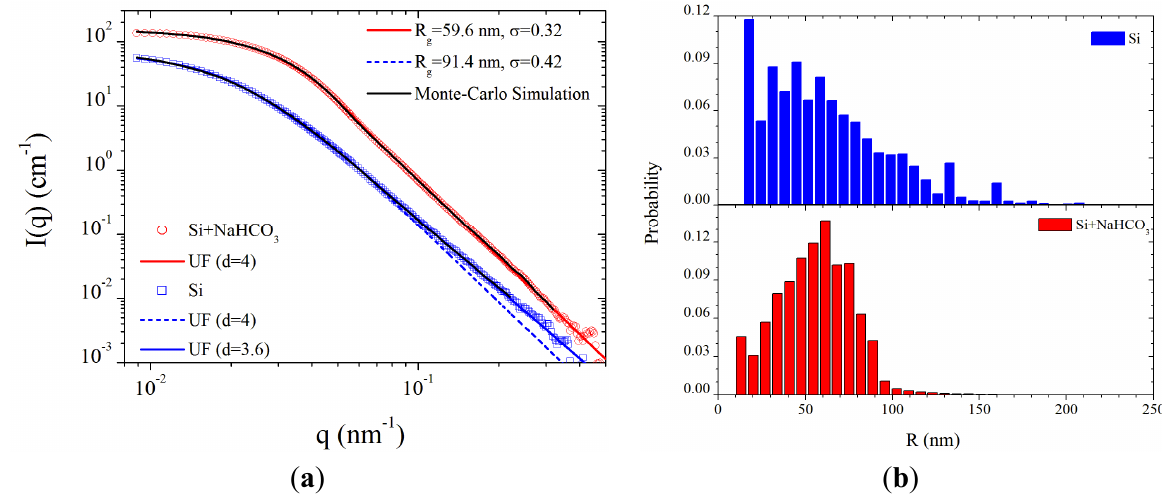
Figure 8. ( a ) Normalized SAXS intensity profiles from the silicon fireball ejected by a graphite electrode in dry air and in damp air with NaHCO respectively), together with model fits; and ( b ) Particle size distribution derived from the best fit Monte-Carlo simulations corresponding to mean particle radii of 62.9 nm and 55.4 nm for the dry and damp conditions,